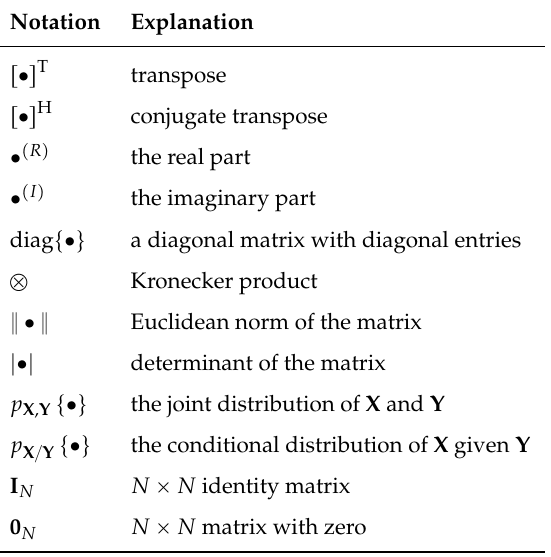
Table 1. Mathematical notation